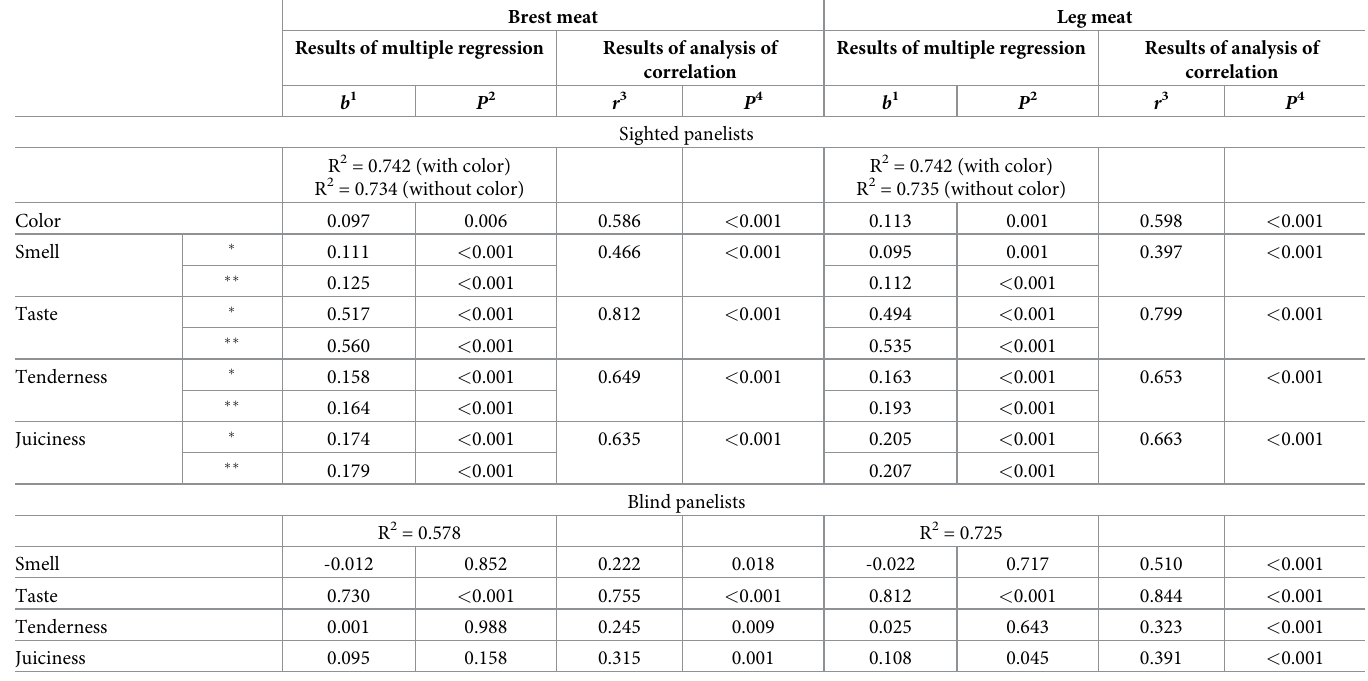
Table 1. Results of multiple regression and analysis of correlations for relationships with poultry meat overall liking (for all types of